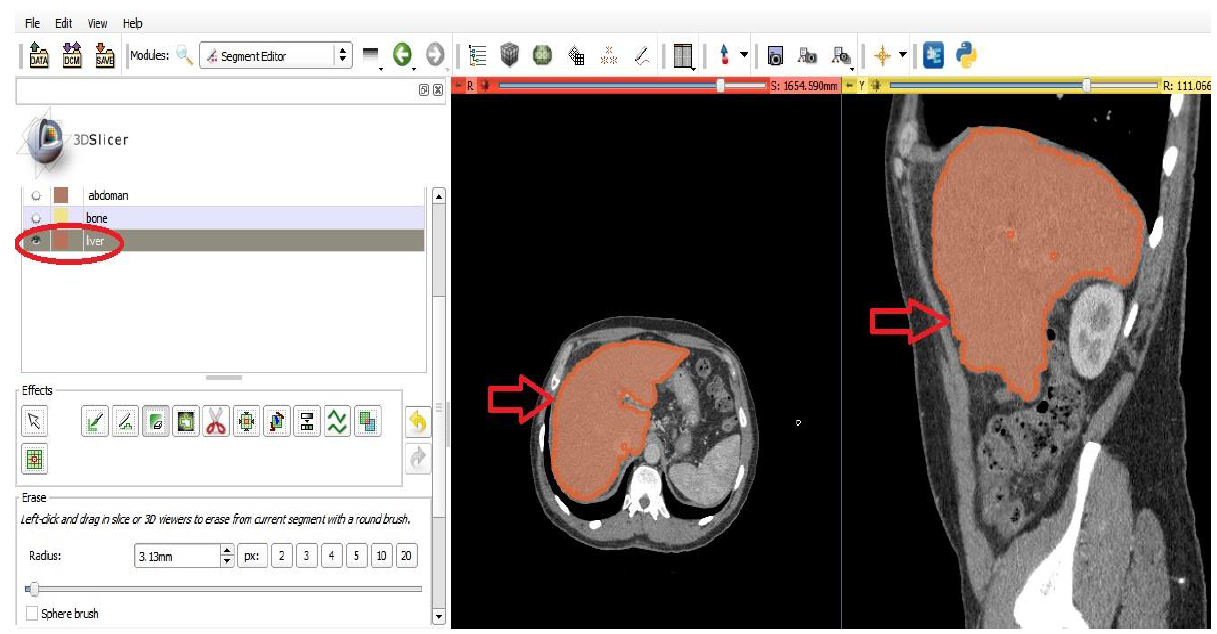
Figure A2: Liver segmentation in 3D